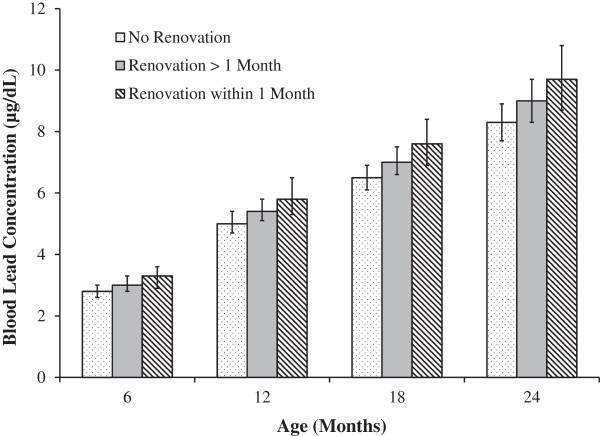
Adjusted blood lead concentration by interior renovation activities at each time point.